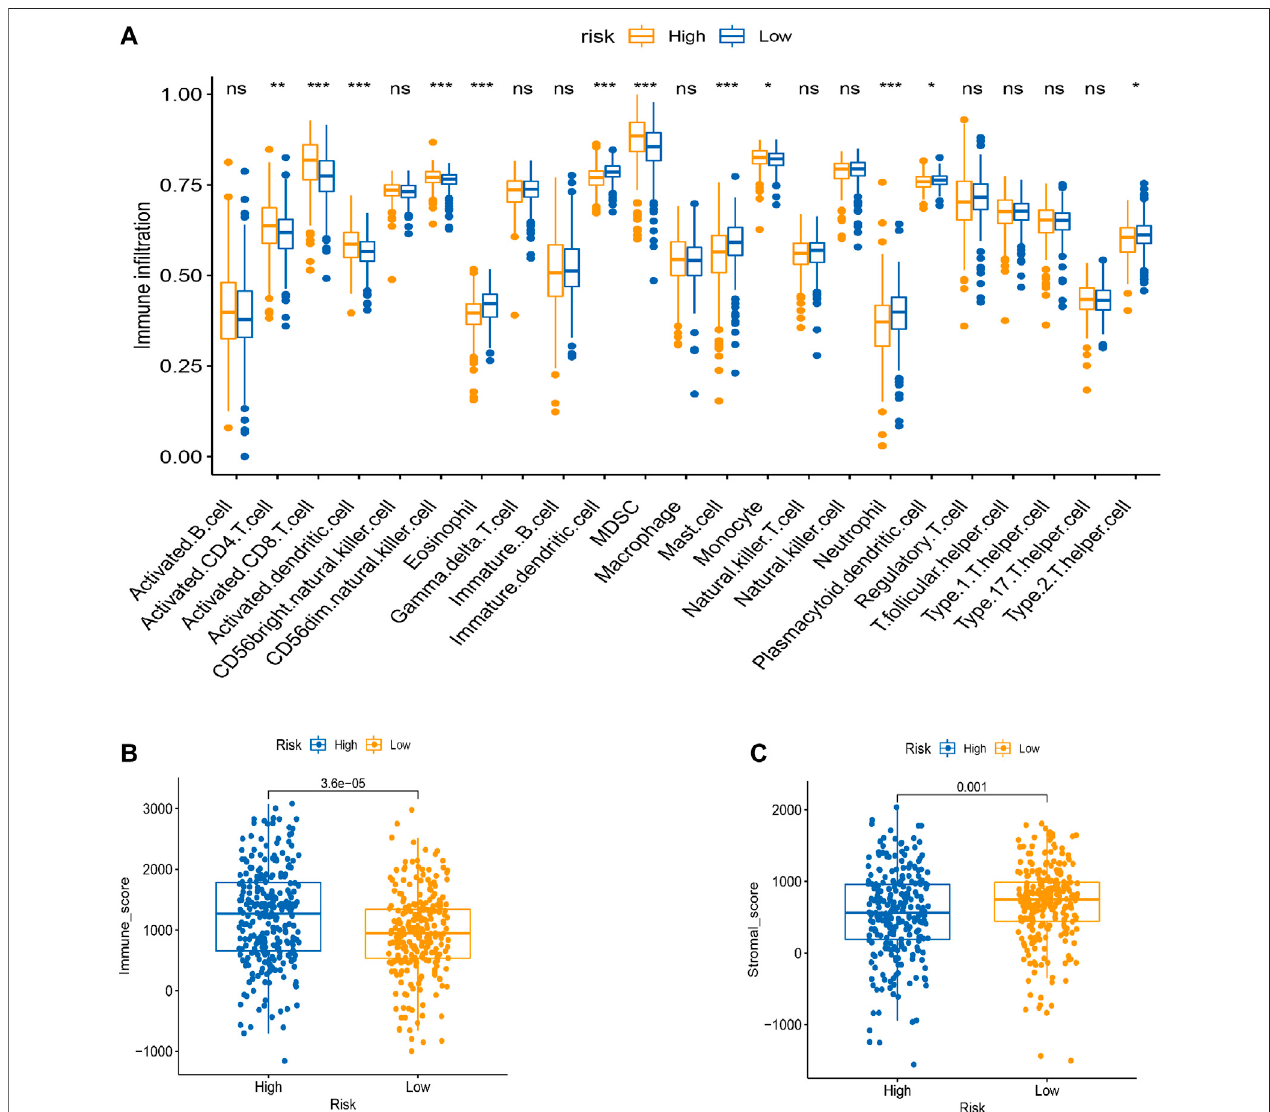
FIGURE 7 | TME cell in fi ltration characteristics in distinct modi fi cation patterns. (A) Box plot for the TME cells in distinct risk groups derived from KIRC patients based on the ssGSEA. The asterisks represented the statistical p value (* p < 0.05; ** p < 0.01; *** p < 0.001). (B – C) Immune and stromal scoreswithin the low- and high- risk groups. (C) Effect of LRPPRC expression level on the expression of different immunomodulators. * p < 0.05, ** p < 0.01, and *** p < 0.001.